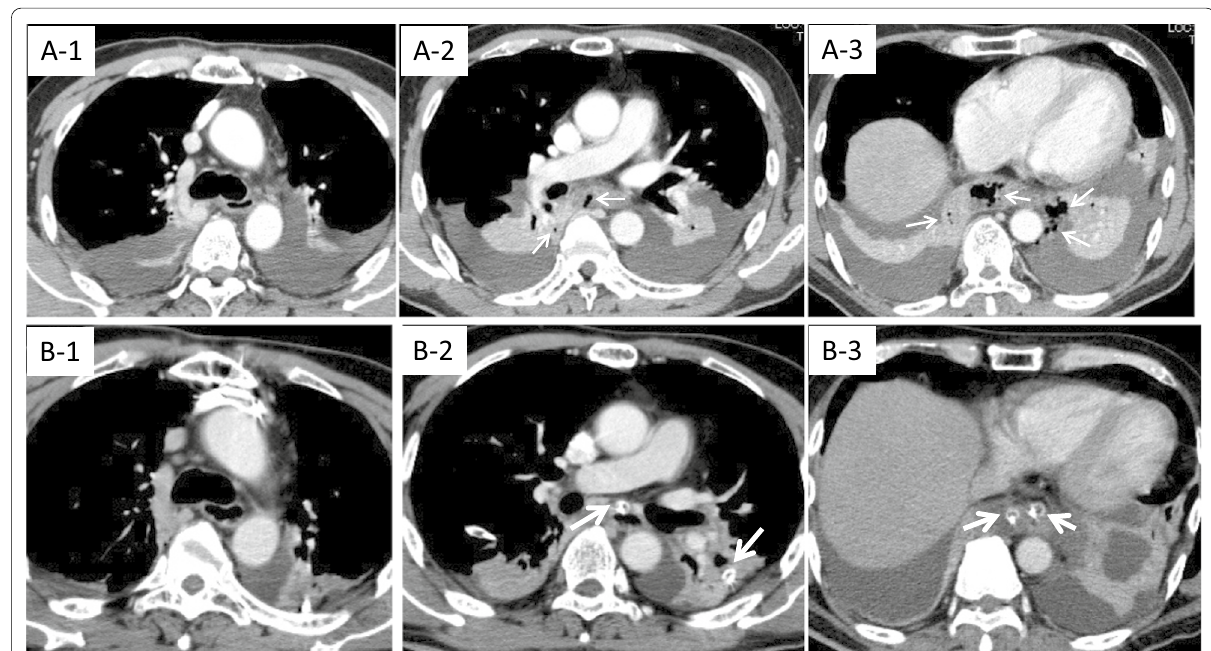
Fig. 5 CT findings before ( A-1,2,3 ) and after ( B-1,2,3 ) an emergency operation. A1 -3. CT before emergency surgery. A-1 Pneumomediastinum is not seen in the branchial bifurcation. A-2,3 Pneumomediastinum is observed (arrow). B1-3 CT after 4 days from emergency surgery . B-1 Pneumomediastinum did not spread above the branchial bifurcation. B-2,3 The drain placed from the abdomen is effective in reducing pneumomediastinum and